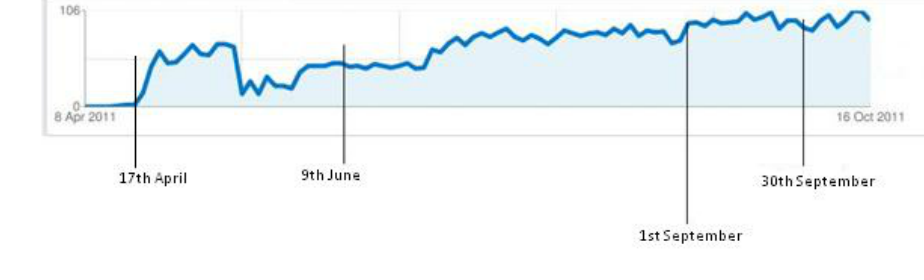
Figure 4. Google Analytics reporting of the number of clicks on the project website www.onlinehelpfordepression.org.uk every two days from start (April 2011) to mid-October 2011, showing period sampled for this study between June 9 and September